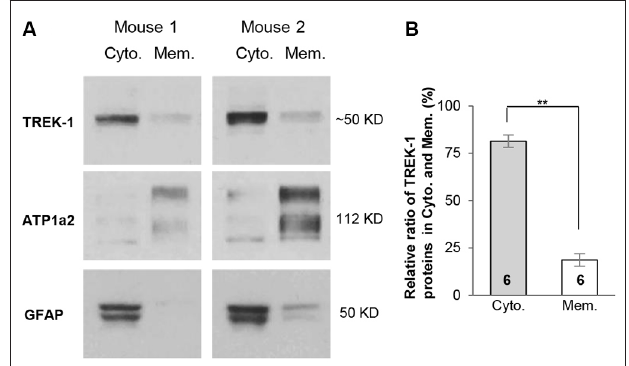
FIGURE 4 | TREK-1 channels are predominantly located in cytoplasm. (A) Fractionation western blot results revealed the subcellular distribution of TREK-1 channels in cytoplasmic fraction vs . membrane fraction in two independent tests of mice hippocampal samples. Anti-glial fibrillary acidic protein (GFAP) (50 kDa) and ATP1 α 2 (112 kDa) were markers for cytoplasmic and membrane fractions, respectively. The blots shown in (A) were first incubated with anti-TREK-1 antibody and then re-probed with the rest of other primary antibodies sequentially after the original membranes were stripped with stripping buffer (see “Materials and Methods” Section). (B) Bar graph summary showing the relative ratio of TREK-1 proteins located in cytoplasmic vs . membrane fractions. Data are shown as mean ± SEM. Numbers indicate the times of observations. ∗∗ p <